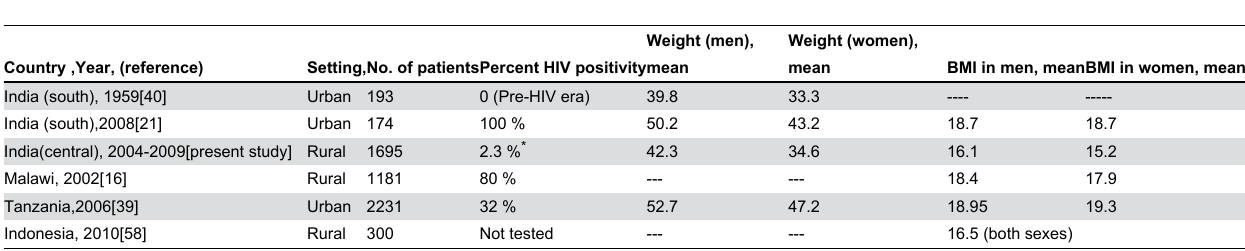
Table 5. Comparative weights and body mass index in patients with pulmonary TB from studies in India and other high TB burden